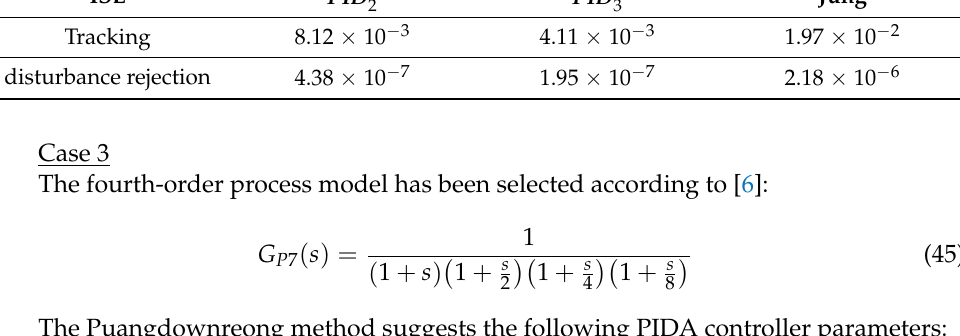
Figure 14. The comparison of the closed-loop responses for the process G P 6 ( s ) when using PID 2 PID 3 and the Jung controller. 3